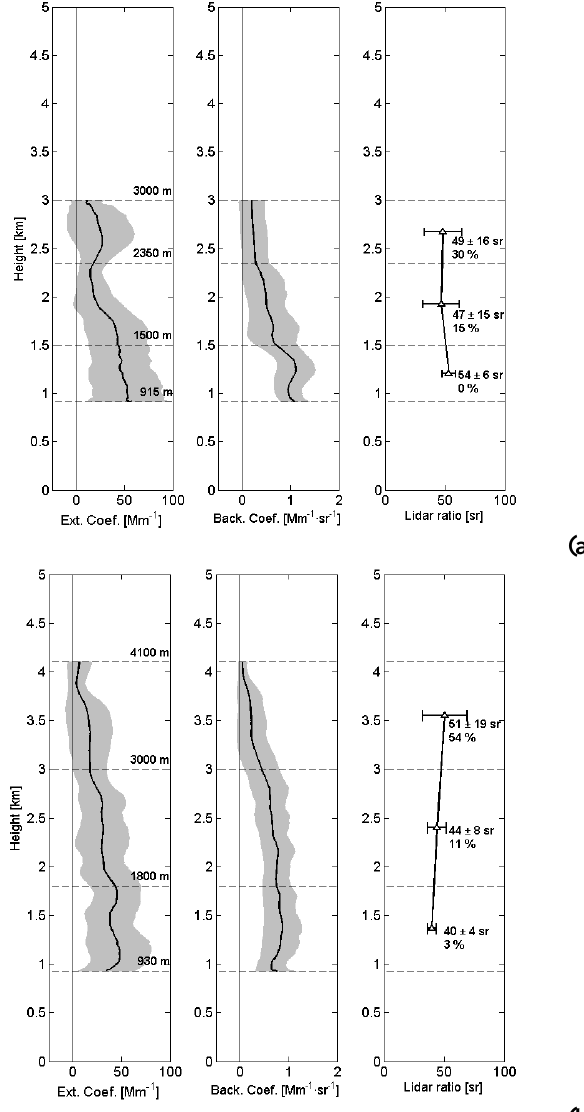
Fig. 7. (a) Winter and (b) summer mean profiles of the extinction coefficient, backscatter coefficient and lidar ratio at 532 nm retrieved from the nighttime measurements. Saharan dust measurements were excluded from this analysis. The grey envelope represents the standard deviation estimation (Eq. (A3)) associated to each range cell of the extinction and backscatter profiles. The fraction of time aerosols are not present (i.e. the aerosol extinction or backscatter coefficients are zero) is indicated for the three height intervals in the lidar ratio plot.